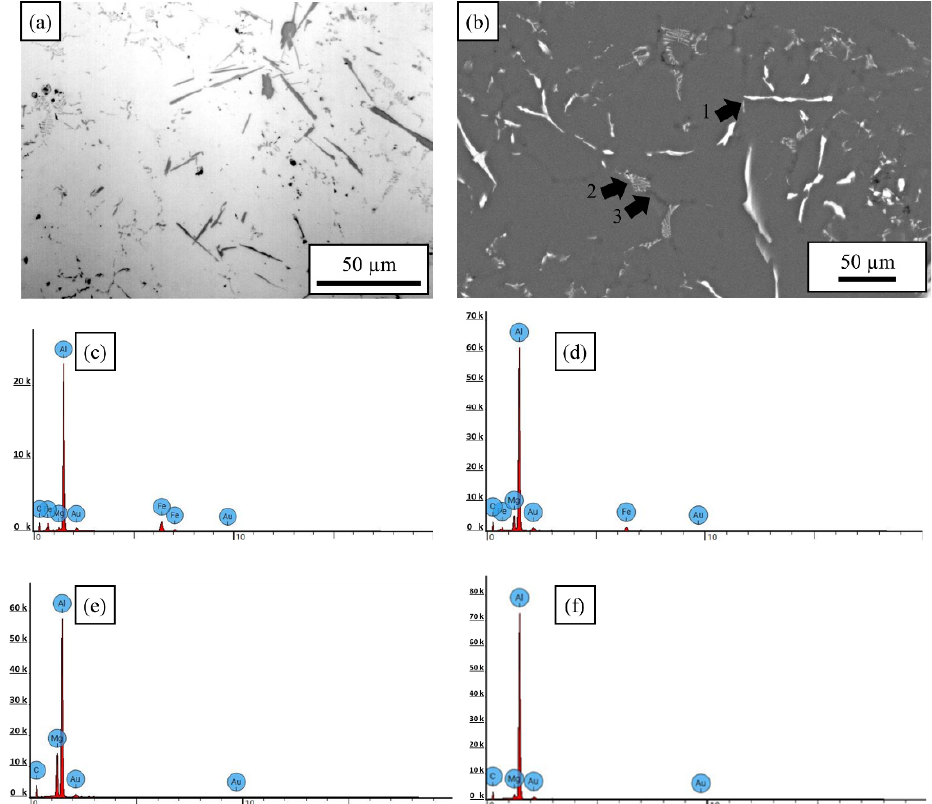
Figure 4. AlMg4Fe2 base microstructure in as-cast state: ( a ) general microstructure view; ( b ) interme- tallic phases in SEM; ( c ) EDX of platelet-intermetallic Al-Fe-Mg particle 1 of ( b ) with low Mg content; and ( d ) EDX of Chinese script Al-Fe-Mg particle 2 of ( b ) with medium Mg content; ( e ) EDX of Al-Mg black particle 3 of ( b ) without any Fe content; and ( f ) EDX of aluminum matrix.